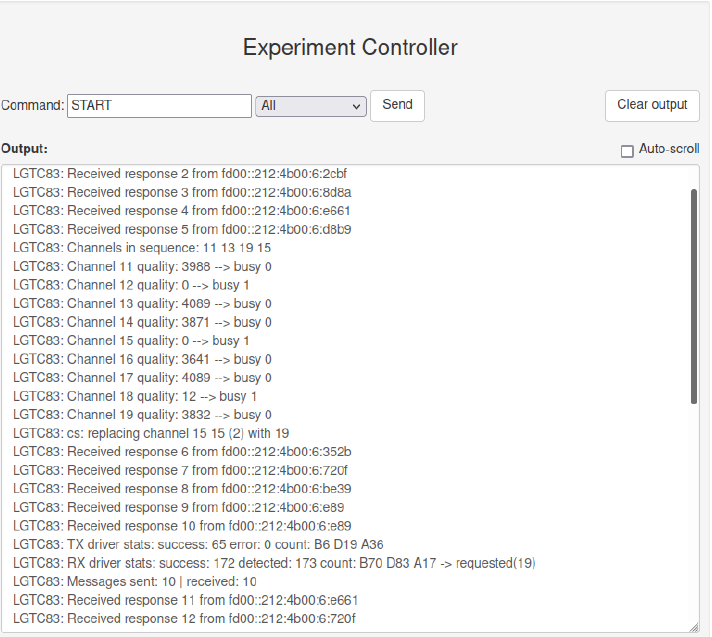
Figure 7. EC and MS output window in experiment run-time for experiment with